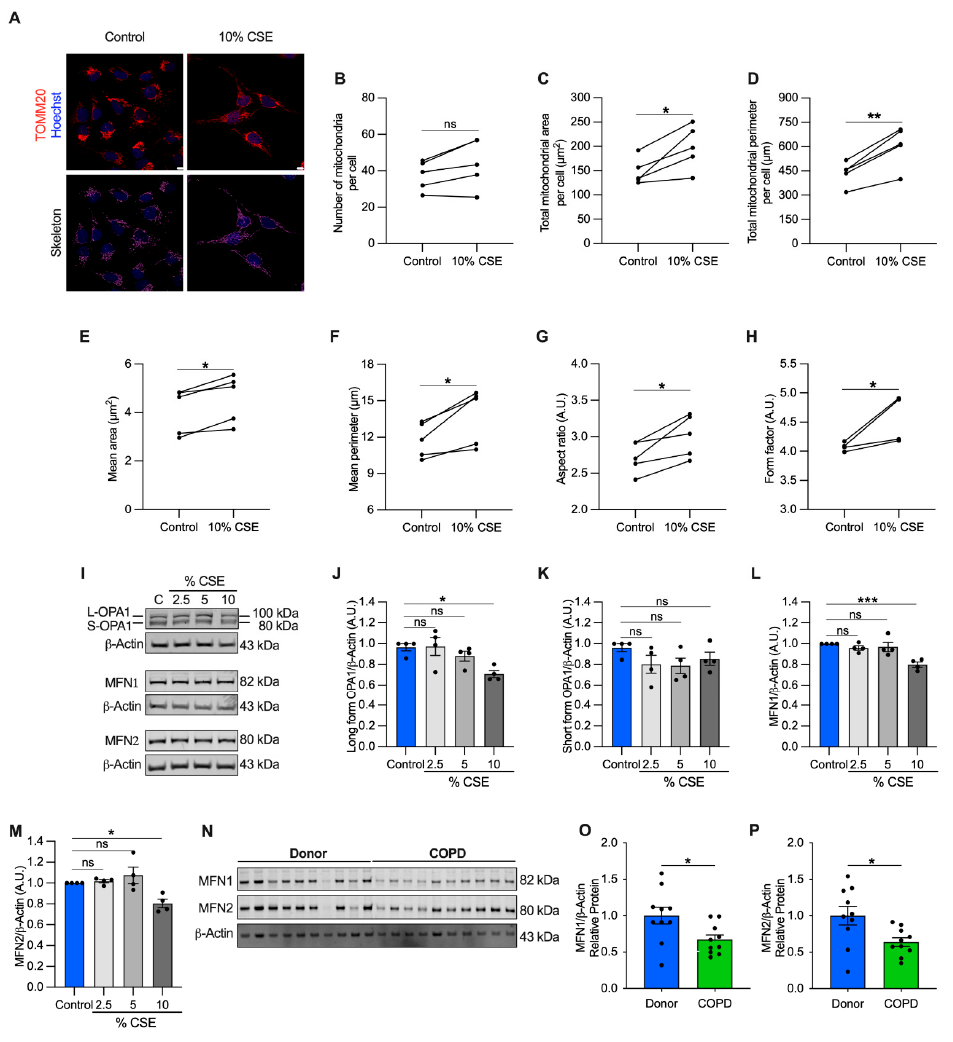
Figure 5. Mitochondrial dynamics are dysregulated in cells exposed to a sublethal dose of CSE and in the airways of COPD patients. ( A ) Representative maximum projections of 3D-confocal images show the mitochondrial network immunolabeled with TOMM20 (red) in control and cells exposed to 10% CSE for 24 h. Nucleus (Hoechst, blue) was used as counterstaining. Greyscale images were converted to binary to generate a skeleton (magenta). Scale bar = 10 µ m; graphs represent ( B ) the number of mitochondria, total mitochondrial ( C ) area and ( D ) perimeter per cell, and the ( E ) mean area, ( F ) mean perimeter, ( G ) aspect ratio (major/minor axis length), and ( H ) form factor (inverse of sphericity) per single mitochondrion; ( I ) representative Western blot of OPA1 (long and short forms, L- and S-, respectively), MFN1, and MFN2 protein levels in BEAS-2B cells exposed for 24 h to increasing doses of (2.5, 5, and 10%) CSE. Bar graphs showing the densitometry of ( J ) long and ( K ) short forms of OPA-1, ( L ) MFN1, and ( M ) MFN2 proteins; ( N ) representative Western blot showing MFN1 and MFN2 proteins, and their relative ( O , P ) densitometry in the airways of human donors without signs of COPD ( n = 10) or affected by COPD ( n = 10). β -actin protein was used as a loading